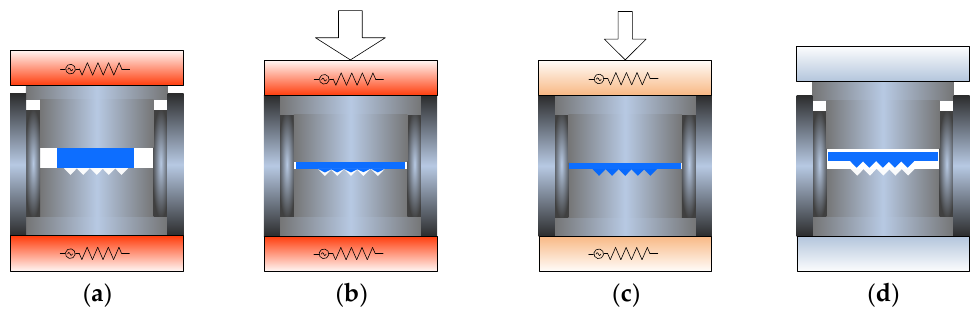
Figure 5. Four stages of a PGM cycle: ( a ) heating, ( b ) pressing, ( c ) annealing, and ( d ) cooling.